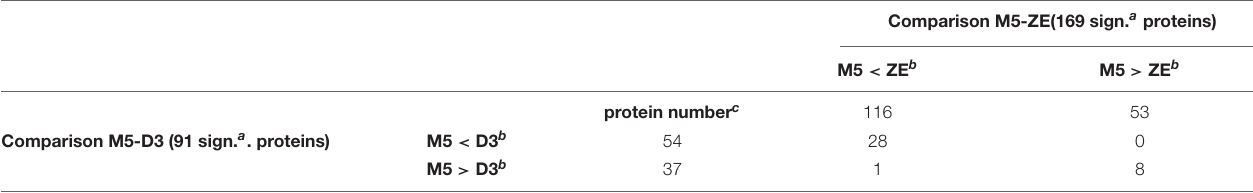
TABLE 2 | Distribution of 224 significant proteins identified in the two proteomic comparisons between cotyledonary somatic embryos matured for five weeks (M5) and fresh cotyledonary zygotic embryos (M5-ZE) or between M5 embryos before and after three weeks of desiccation (M5-D3), in the function of the overexpression ways. Comparison M5-ZE(169 sign. a proteins)